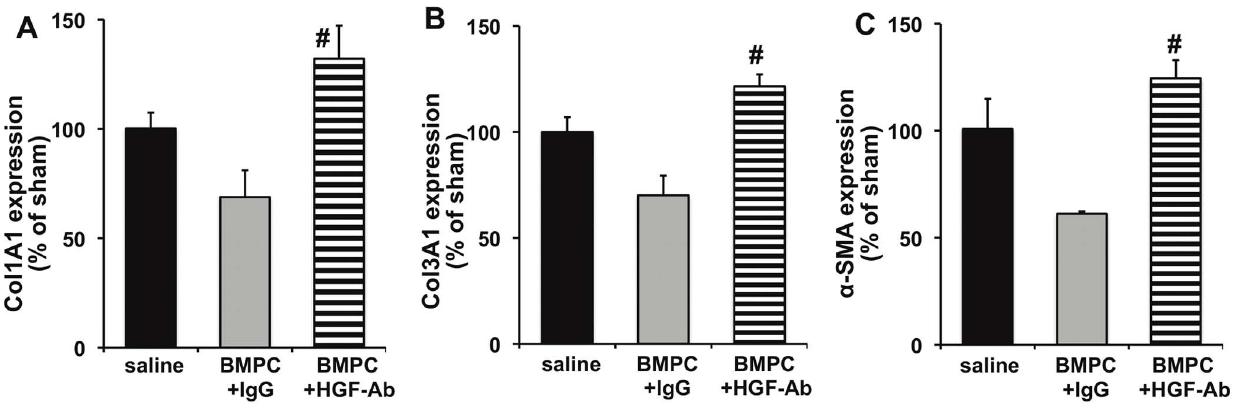
Figure 6. Expression of fibrotic markers (at 28 day post-MI) in infarcted hearts of db/db mice receiving BMPC intramyocardial. BMPC therapy reduced MI-induced mRNA expression (measured by qRT-PCR) of Col1A1, Col3A1 and a -SMA in comparison with saline-treated group. Administration of neutralizing antibodies against HGF (HGF-Ab) significantly aggravated fibrotic response as compared to IgG treated group. # P , 0.05 versus IgG treated group. HGF-Ab indicates antibodies against hepatocyte growth factor; Col1A1, collagen type 1 alpha 1; Col1A1, collagen type 3 alpha 1; a -SMA, alpha smooth muscle actin; BMPC, bone marrow-derived progenitor cell. BMPC, bone marrow-derived progenitor cell.